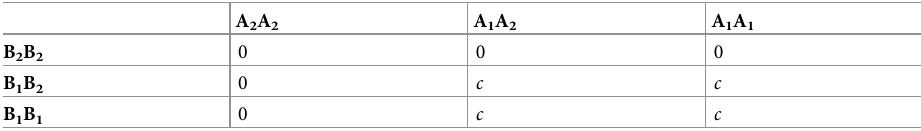
Table 3. Genotypic values of a 2-locus complementary